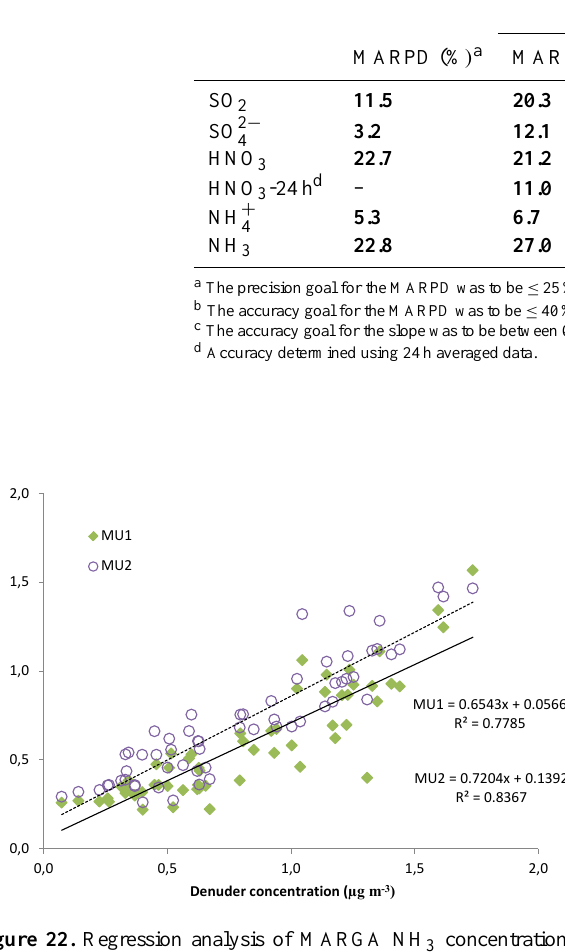
Figure 21. Denuder and MU measured NH 3 concentrations (after adjusting for the external standard as an offset from 19:00 on 23 September onwards) during the ETV period. Table 2. Summary of the performance of the MARGA in achieving accuracy and precision goals. Bolded values indicate the goal was passed. Precision